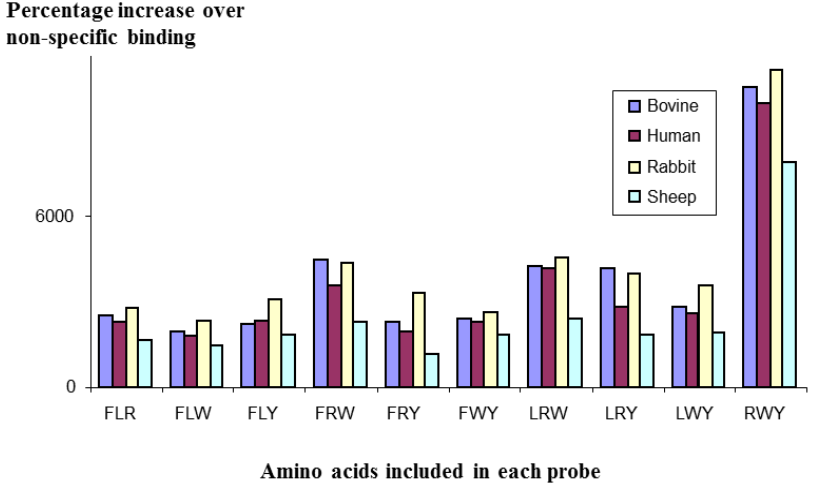
Figure 3. Binding of a Mozaic micelle library to IgG from different species, showing strong similarities in profile, suggesting that the structure recognised by the micelles is the same across all the species